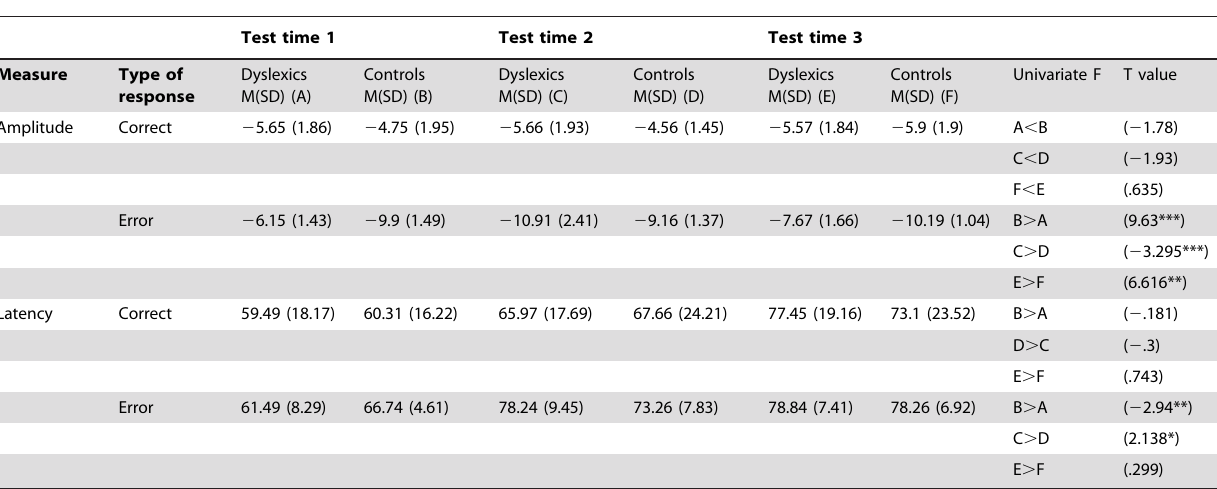
Table 5. Amplitudes and latencies of response-locked ERP